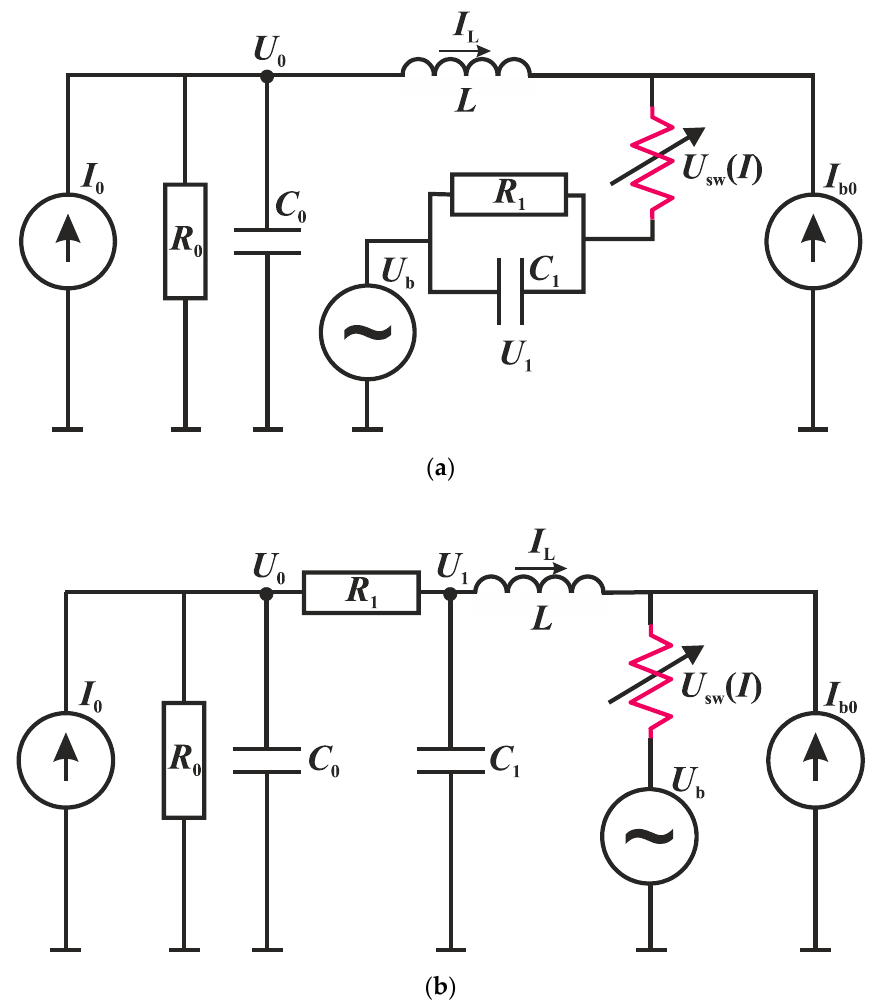
Figure 9. An oscillator circuit that implements the FitzHugh–Rinzel model with a high-pass R 1 C 1 -filter connected in series to the switch ( a ) and a low-pass R 1 C 1 -filter connected between the capacitor C 0 and the inductance L ( b ).